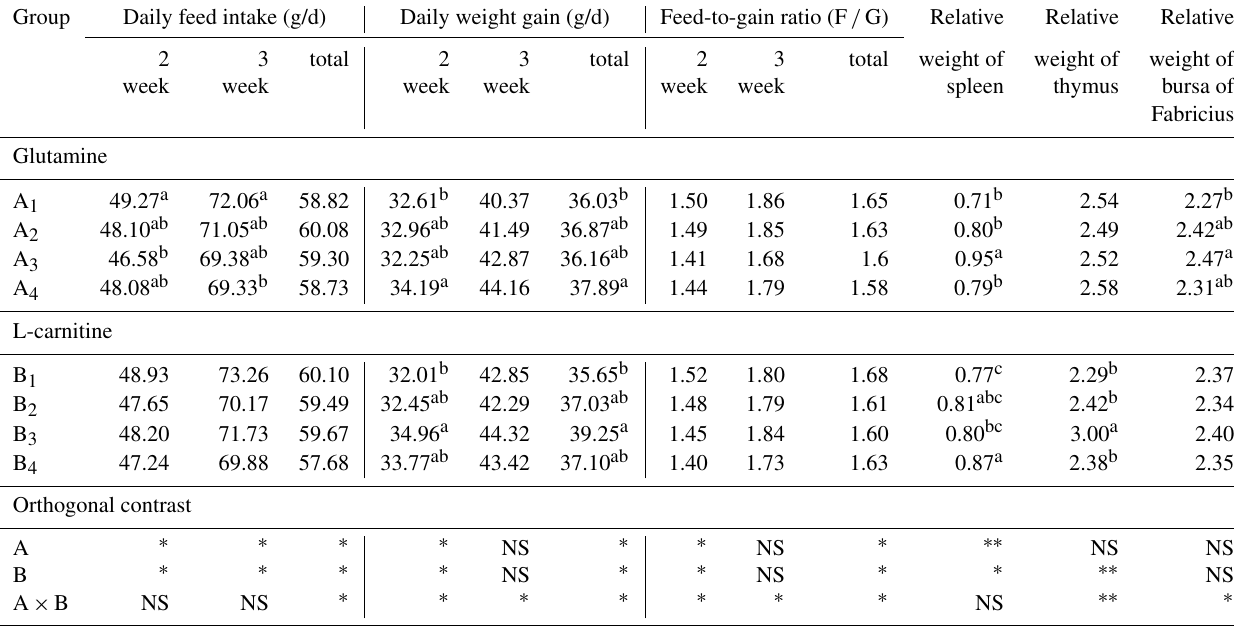
Table 4. The effects of supplemented glutamine and L-carnitine on growth performance and organ’s relative weight of Arbor Acres broilers under low temperature conditions.